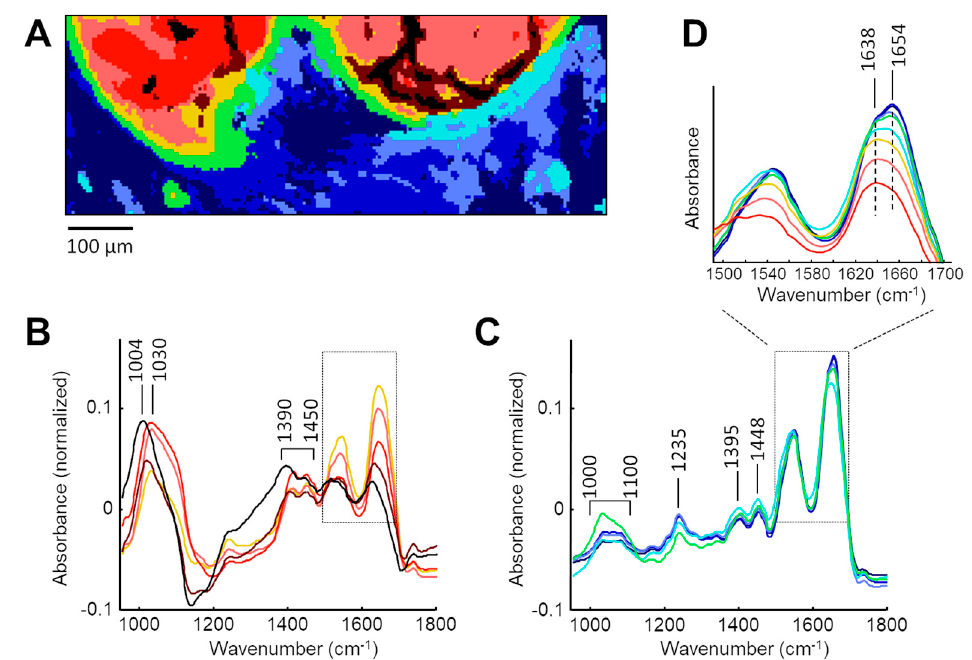
Figure 3. Results from k-means cluster analysis of the spectroscopic data set registrated from the calcified aortic valve leaflet (see Figure 1). ( A ) assignment of clusters. ( B , C ) corresponding cluster centroid spectra. ( D ) enlarged plot of selected centroid spectra in the region of amide I and amide II bands.